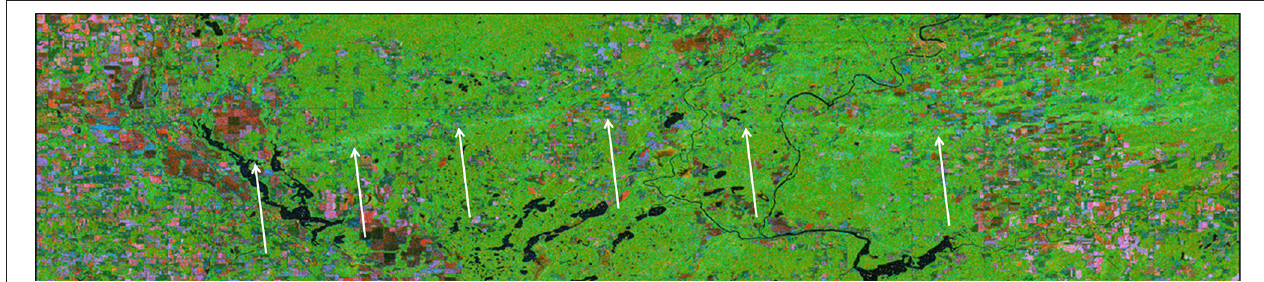
FIGURE 5 | Synthetic Aperture Radar (SAR) temporal difference image (before-and-after) of the tornado track from May 16, 2017 near Clear Lake, WI. Imagery acquired by Sentinel-1(A/B), a European Space Agency (ESA) satellite with a SAR instrument on board. The above image is the result of differencing images from May 10 and May 22, 2017. Image credit: Lori Schultz, NASA SPoRT (public domain).